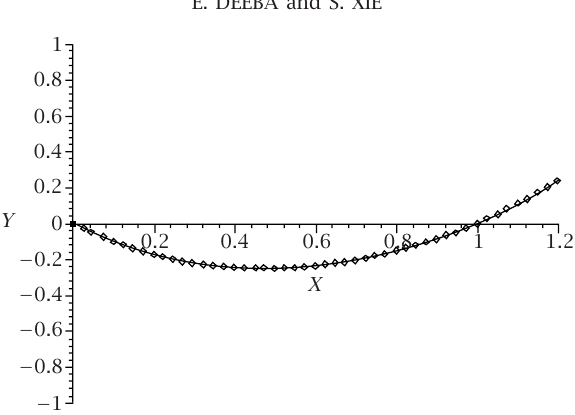
Figure 3.1 . Decomposition method versus analytic solution for y(x) =